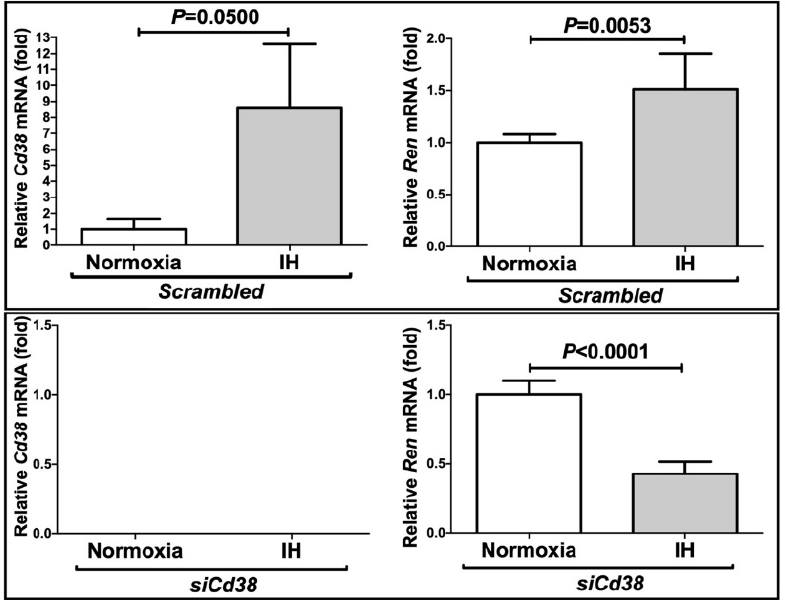
Figure 5. Effects of the siRNA against Cd38 on the IH-induced gene expression of Ren and Cd38 . The siRNA for Cd38 was transfected into the As4.1 JG cells and the cells were then subjected to IH or normoxia for 24 h. The levels of the Ren and Cd38 mRNAs were measured via a real-time RT-PCR using Rig/RpS15 as an endogenous control. The data are expressed as the mean ± SE for each group of six independent experiments (n = 6). The statistical analyses were performed using a Student’s t -test. No Cd38 mRNA was detected in the siCd38 -introduced cells.